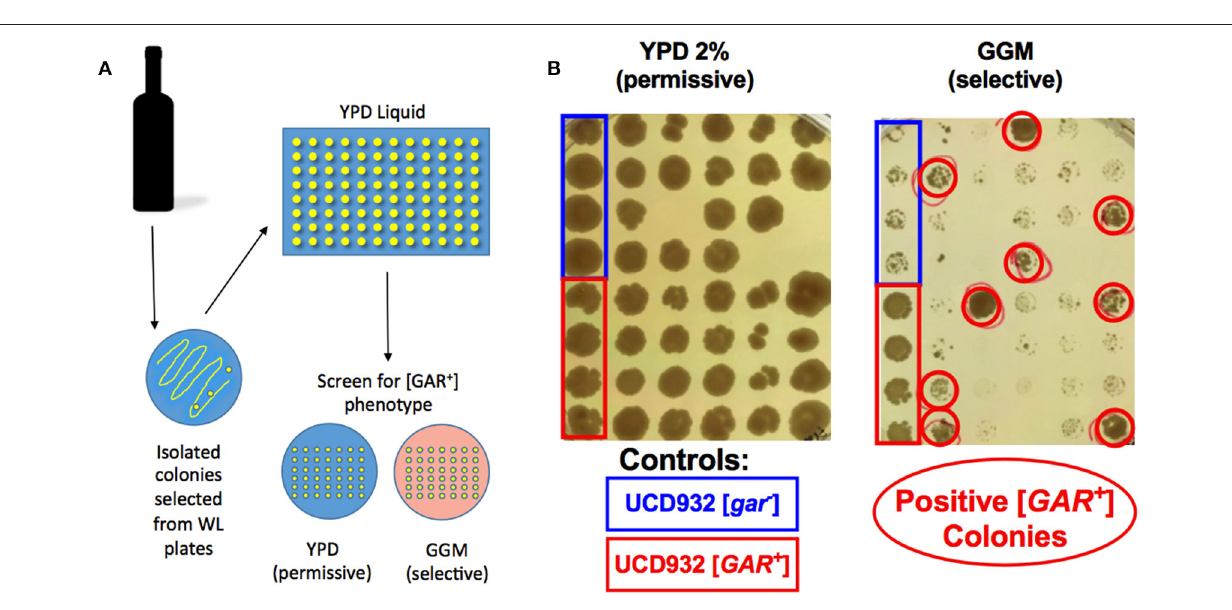
FIGURE 6 | Screen for [ GAR + ] yeast from stuck fermentations. Isolates of Saccharomyces cerevisiae from stuck fermentations were arrayed in 96 well plates such that four replicates of [ gar − ] and [ GAR + ] controls and 40 isolates would be included in each of the two petri plates created from the 96 well plate (A) . Replicate plating of each half of the 96 well plate was done onto non-selective or permissive medium (YPD) and selective medium (GGM) to screen for possible [ GAR + ] phenotype in the stuck fermentation (B) . Red circles indicate colonies expressing the [ GAR + ]